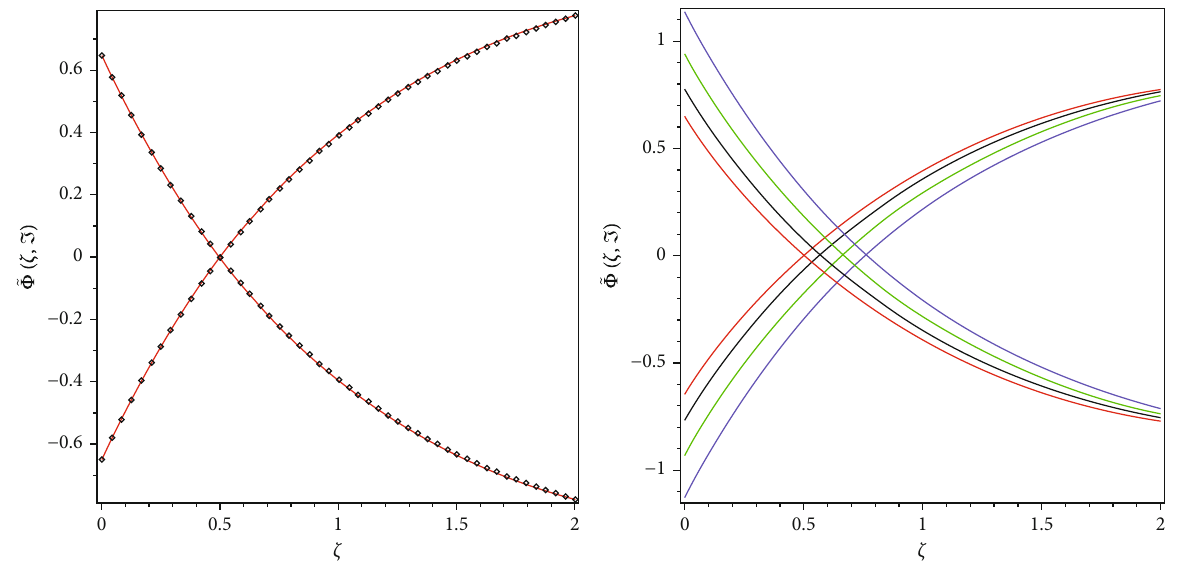
Figure 6: First graph shows the two-dimensional fuzzy lower and upper branch graph of analytical series solution and second graph the di ff erent fractional-order of ν